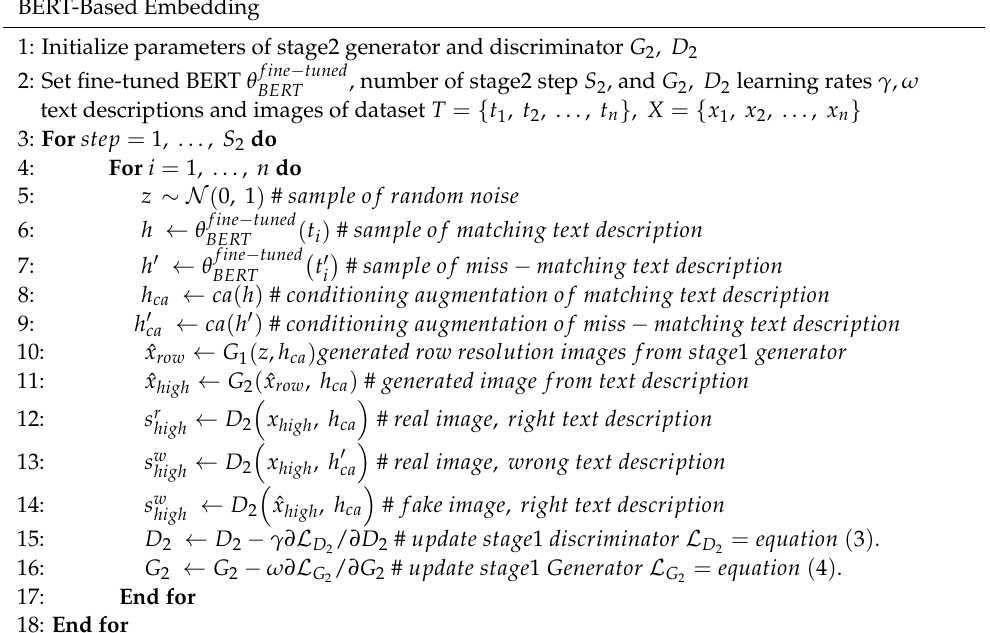
Algorithm 3 Realistic High-Resolution Image Generation from Text by Using